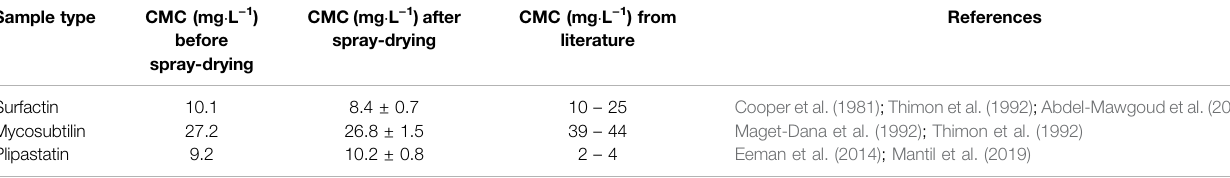
TABLE 1 | Critical micellar concentration of the lipopeptides produced by Bacillus subtilis before and after spray-drying process. Sample type